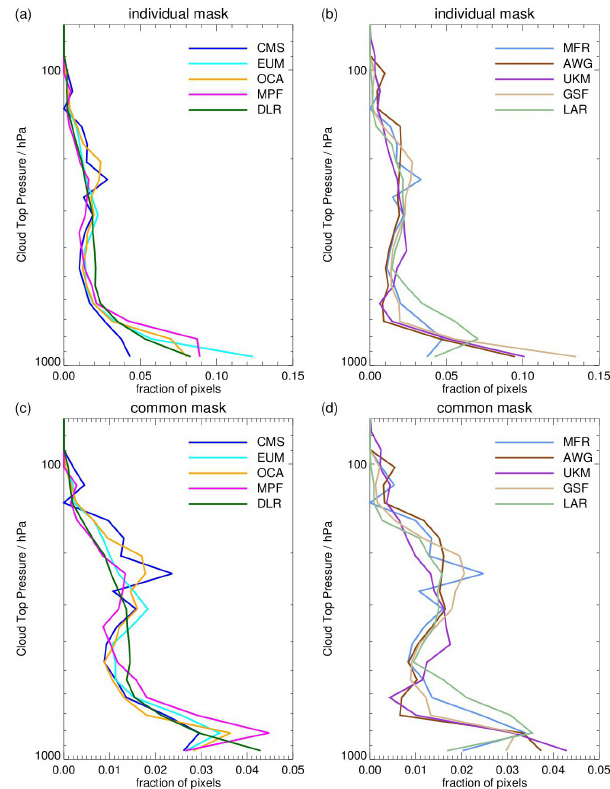
Figure 4. Histograms of the cloud top pressure for 13 June 2008, 12:00–15:30UTC. In panels (a) and (b) all retrieved values are taken into account, whereas in panels (c) and (d) only observations are taken into account, for which all ten retrievals detect a cloud and derive a CTP.